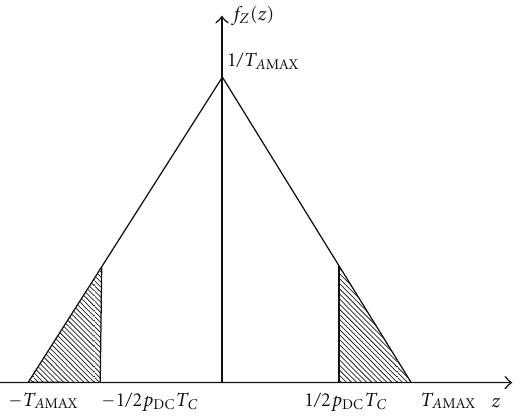
Figure 6: Probability distribution function of z = T TX1 − T A MAX + p P ( | z | ≥ p / 2 T T e DC = C ) (area of the shadow regions). TX3 and DC